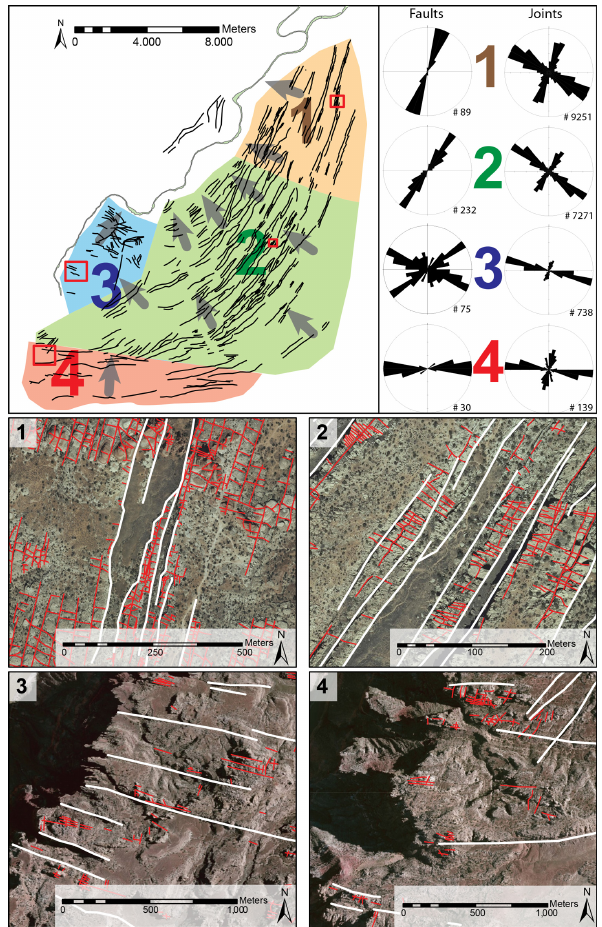
Figure 4. Fault and joint orientations in the Needles fault zone derived from airborne image mapping. Four sections group areas of similar orientations. One joint set is always parallel to the ma- jor faults. Small red rectangles depict locations of associated de- tail photographs showing the interpretations of faults (white lines) and joints (red lines). Numbers 1–4 on the photographs correspond to the sections. Gray arrows indicate the local direction of graben